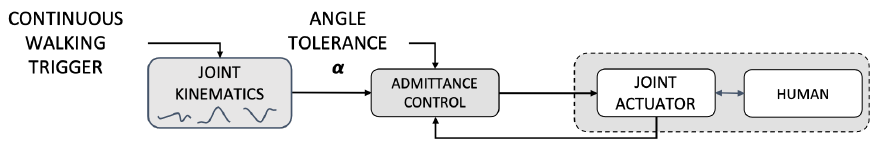
Figure 2. Conceptual diagram of the Exo-H3 admittance control.